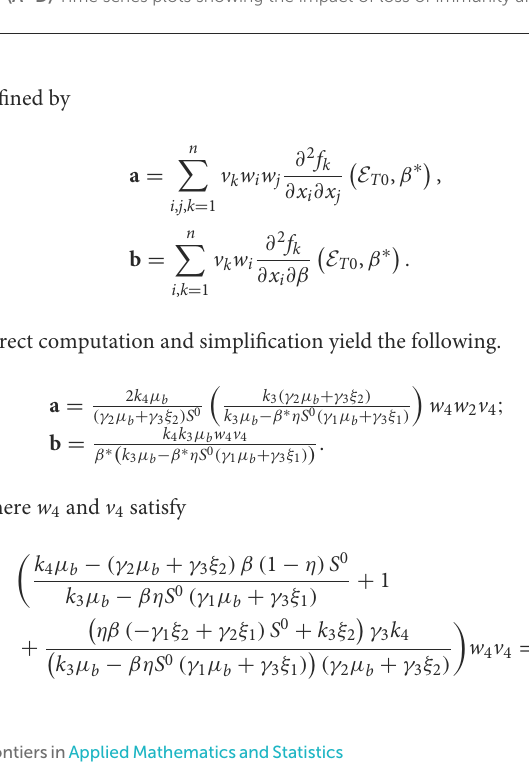
FIGURE7 (A–D) Time series plots showing the impact of loss of immunity after the first vaccination.